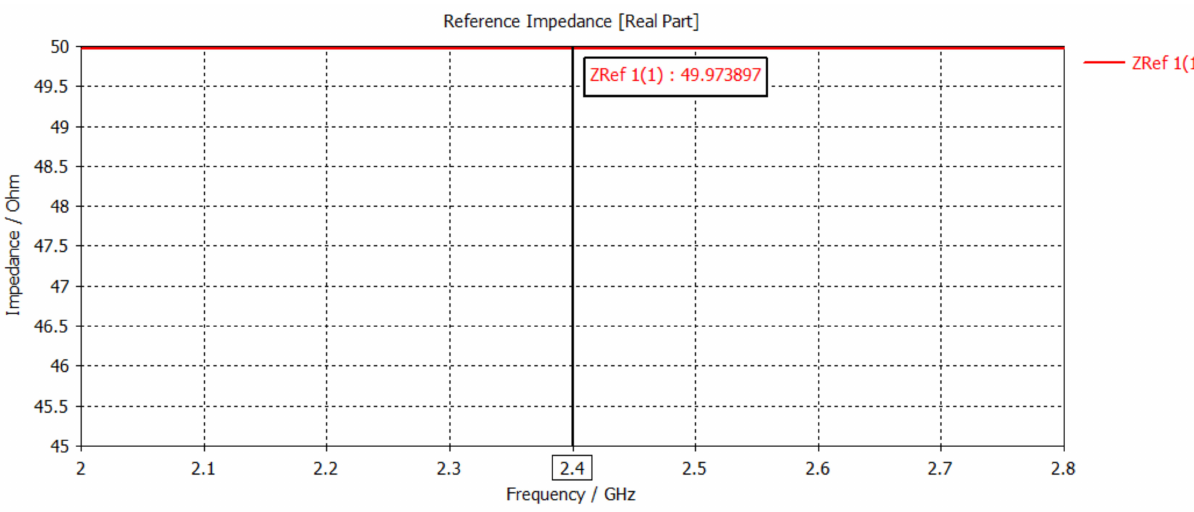
Figure 16. Impedance by frequency in new design of patch antenna of 2.4 GHz with line transmission λ /4.